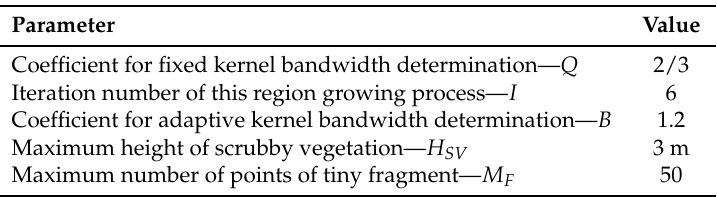
Table 2. Experimental